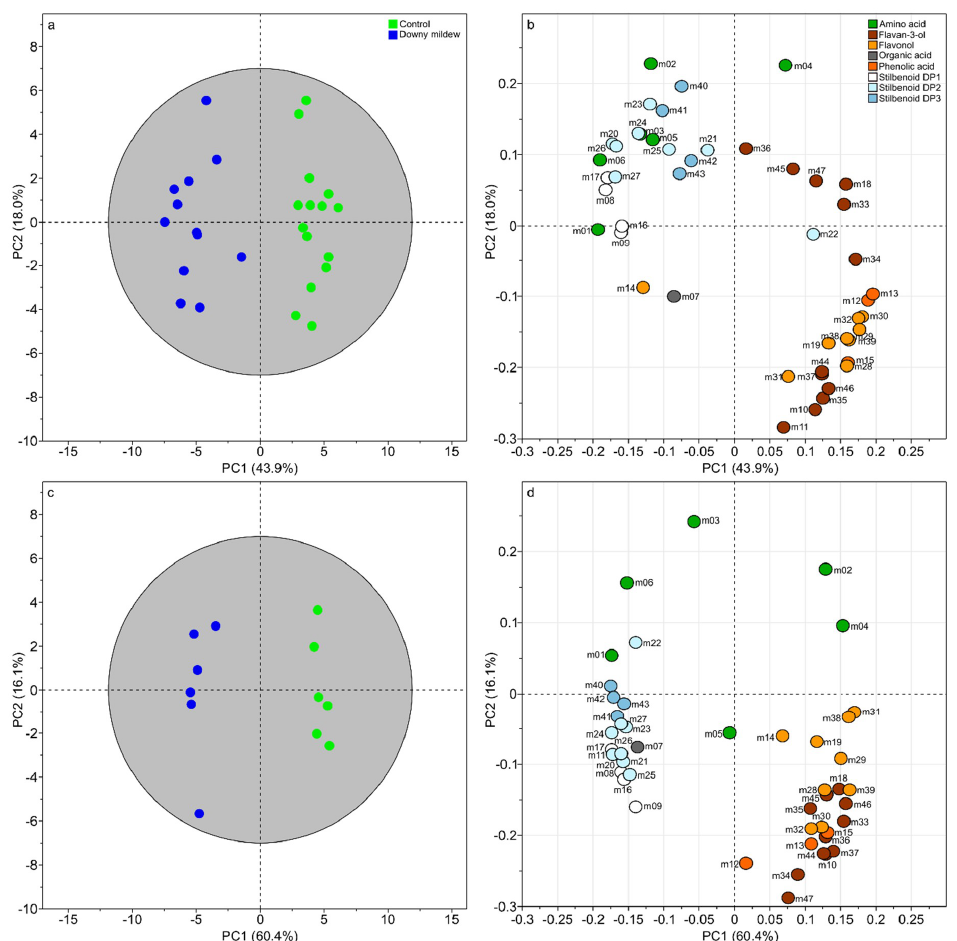
Figure 2. Supervised classification using orthogonal partial least squares discriminant analysis (OPLS-DA) with “infection status” as discriminant variable at 6 dpi ( a, b ) and 15 dpi ( c, d ). Score plot ( a ). Loading plot ( b ). Numbers indicate the ID of the compounds as given in Table 1. 2.4. Metabolic Network Analysis of Grape Leaves Upon Downy Mildew.